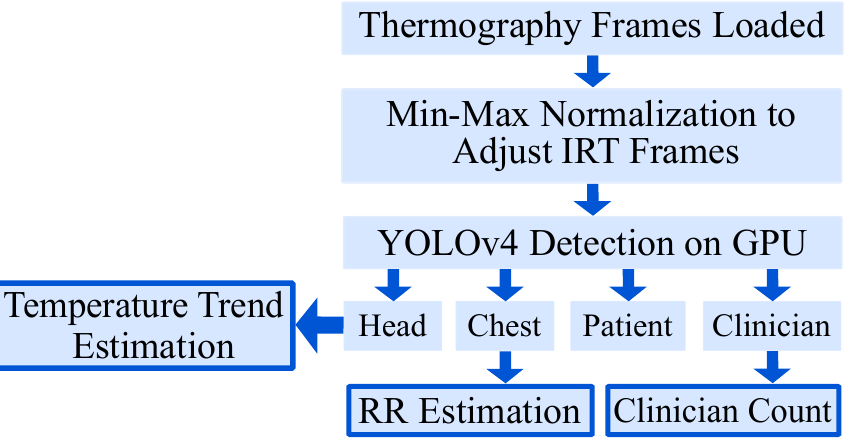
Figure 3. Overview of the segmentation algorithm.